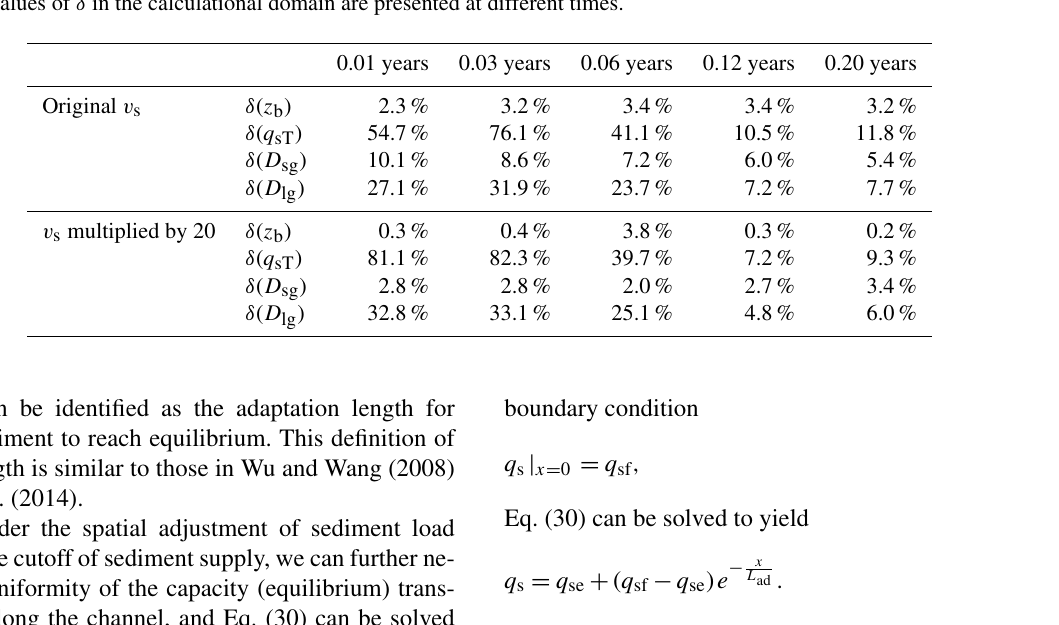
Figure 6. The 0.2-year results for the case of sediment mixtures using the flux form of the Exner equation: time variation of (a) bed elevation z b and water surface (WS), (b) total sediment load q sT , (c) surface geometric mean grain size D sg , and (d) geometric mean grain size of sediment load of the LYR in response to the cutoff of sediment supply. The inset shows detailed results near the upstream end. Table 3. Quantification of the difference between predictions of the flux form and the entrainment form in the case of sediment mixtures. The maximum values of δ in the calculational domain are presented at different